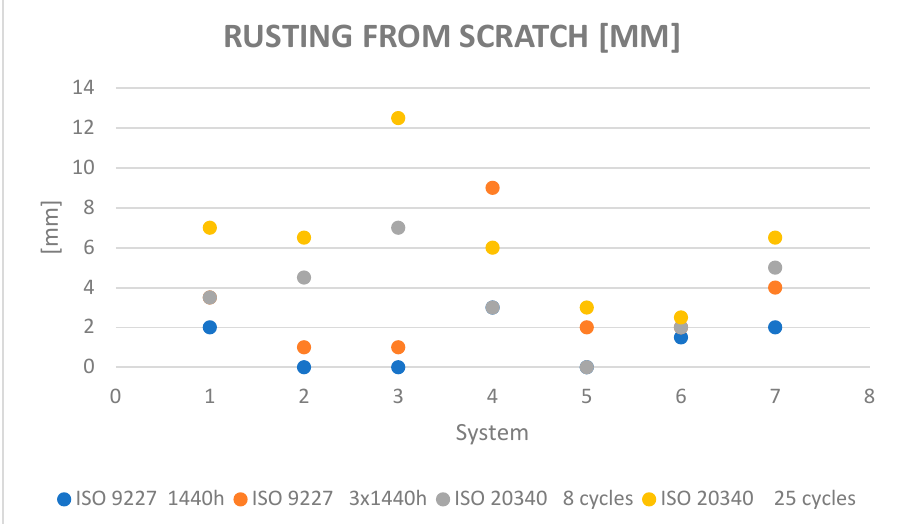
Figure 5. Rusting from the scratch measured according to ISO 4628 ‐ 8:2012 [8].